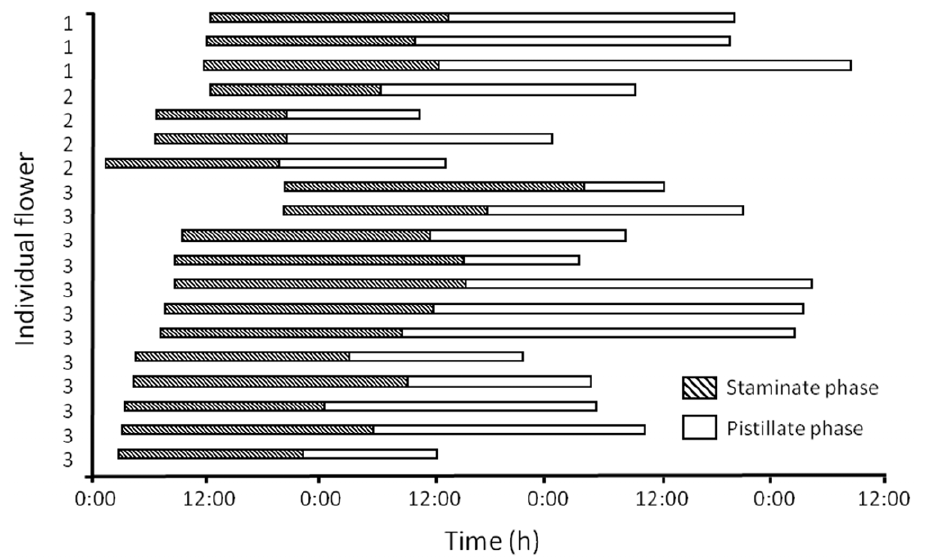
Figure 1. Flowering phenology of 19 flowers on three C.trichotomum plants. The hatched bar indicates the staminate phase and the white bar represents the pistillate phase. Numbers denote individual plants.